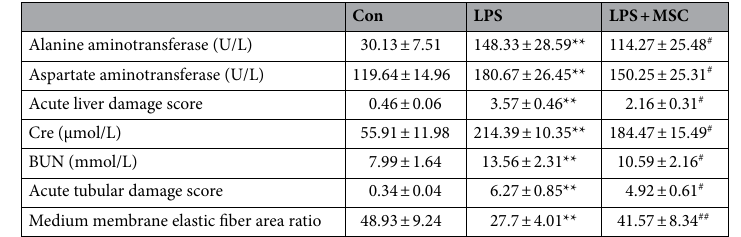
Table 3. The degree of organ injury. LPS injection increased the levels of the liver damage markers ALT and AST and the kidney damage markers Cre and BUN, which was improved by BM-MSCs administration. LPS administration increased the aortic intima media-thickness, which was reversed by BM-MSCs administration. Values are expressed as the mean ± SD. # P < 0.05 versus the LPS group. ** P < 0.01 versus the Sham group. ## P < 0.01 versus the LPS group.